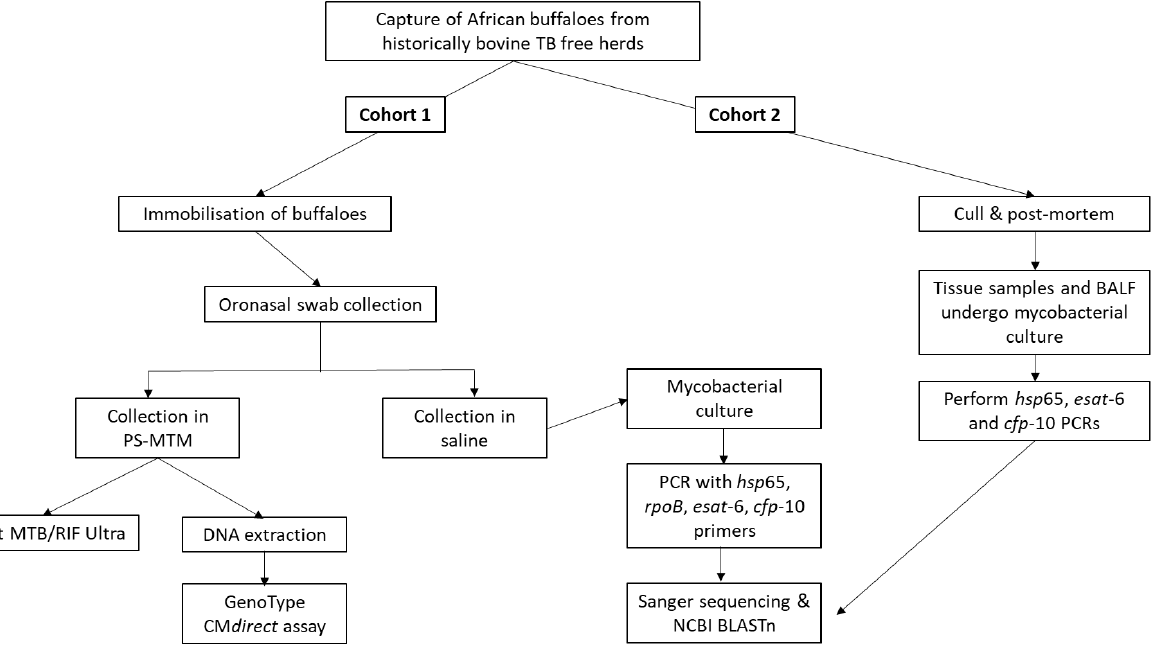
Figure 3. Flow chart indicating the study methods involved in the detection and characterisation of nontuberculous mycobacteria in African buffaloes. PS-MTM, PrimeStore ® Molecular Transport Medium; BALF, bronchoalveolar lavage fluid.